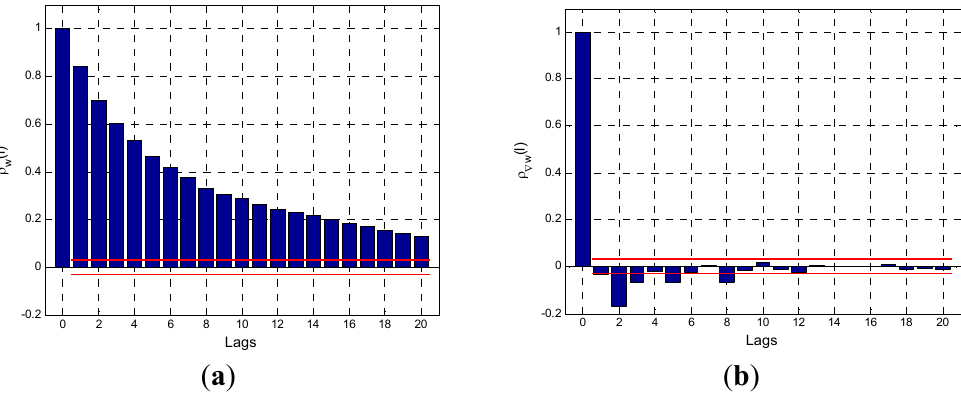
Figure 1. Autocorrelation coefficients of observations of wind speed and